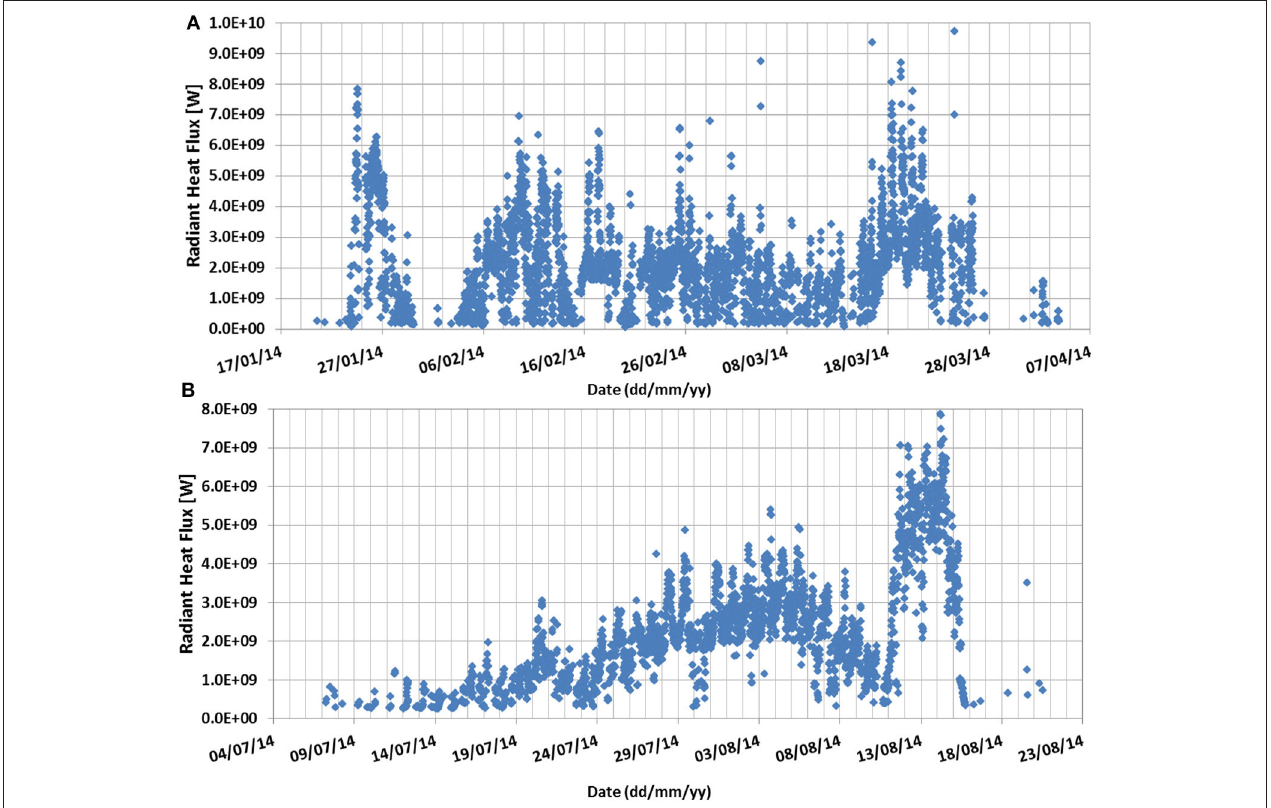
FIGURE 2 | Radiant heat flux curves computed from SEVIRI data for the two long effusive events occurred between 22 January and 7 April 2014 (A) and from 7 July to 20 August 2014 (B)